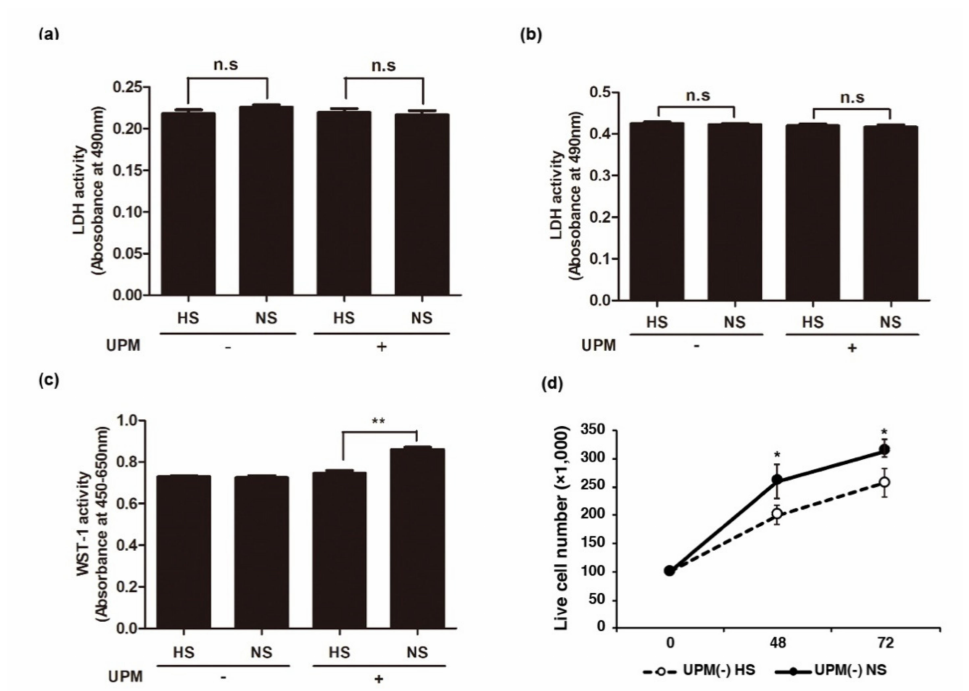
Figure 4. Cell death and proliferation of UPM-treated HUVECs with human serum. ( a ) LDH assay in UPM-treated HUVECs incubated with heated human serum (HS) or normal human serum (NS) for 1 h. Untreated (UPM-) or UPM-treated HUVECs (UPM+) incubated with HS or NS for 1 h. LDH activities were measured in the supernatant of the cultured cells. Results are shown as mean ± SD, n = 5, Two-way ANOVA with multiple comparisons. n.s: not significant. ( b ) LDH assay in UPM- treated HUVECs incubated with HS or NS for 48 h. After complement activation for 1 h, culture medium was replaced with fresh medium to remove UPM and human serum. Cells were incubated for 48 h, and cell death was measured by LDH assay. Results are shown as mean ± SD, n = 5, Two-way ANOVA with multiple comparisons. n.s: not significant. ( c ) Proliferation of HUVECs with UPM-mediated complement activation. Heated or normal human serum was applied to UPM-treated HUVECs for 1 h, after which the media were replaced to remove UPM and human serum. After incubation with fresh media for 48 h, cell proliferation was measured using the WST-1 assay. Results are shown as mean ± SD, n = 5, Two-way ANOVA with multiple comparisons. ** p < 0.01. ( d ) Analysis of live cell numbers of HUVECs with UPM-mediated complement activation. Trypan blue exclusion assay was applied to cell count at 48 h and 72 h after exposure of UPM. Student- t test. Results are shown as mean ± SD, n = 3, * p <